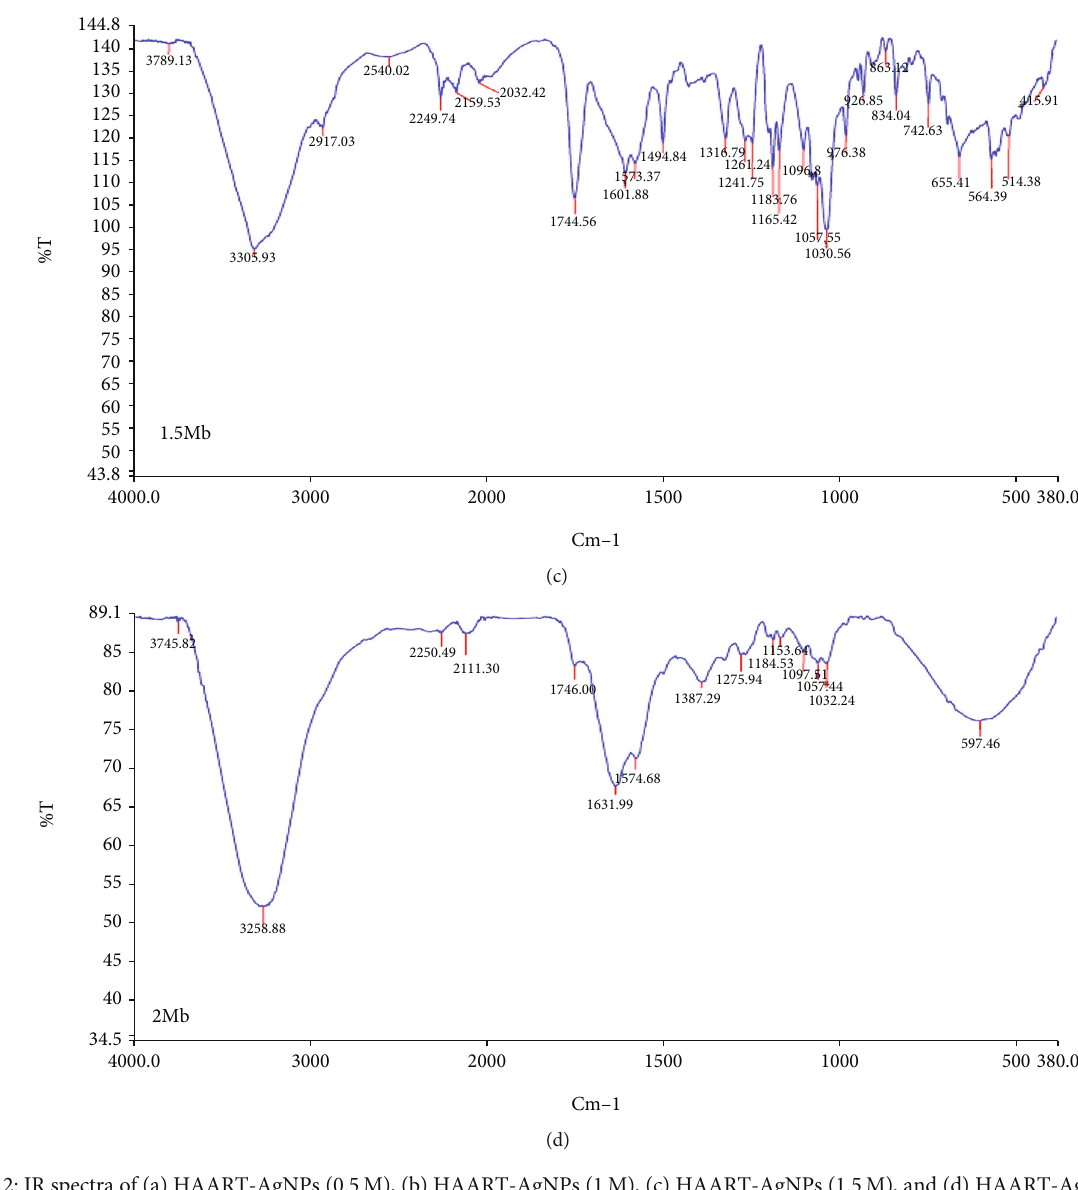
Figure 2: IR spectra of (a) HAART-AgNPs (0.5M), (b) HAART-AgNPs (1 M), (c) HAART-AgNPs (1.5M), and (d) HAART-AgNPs (2